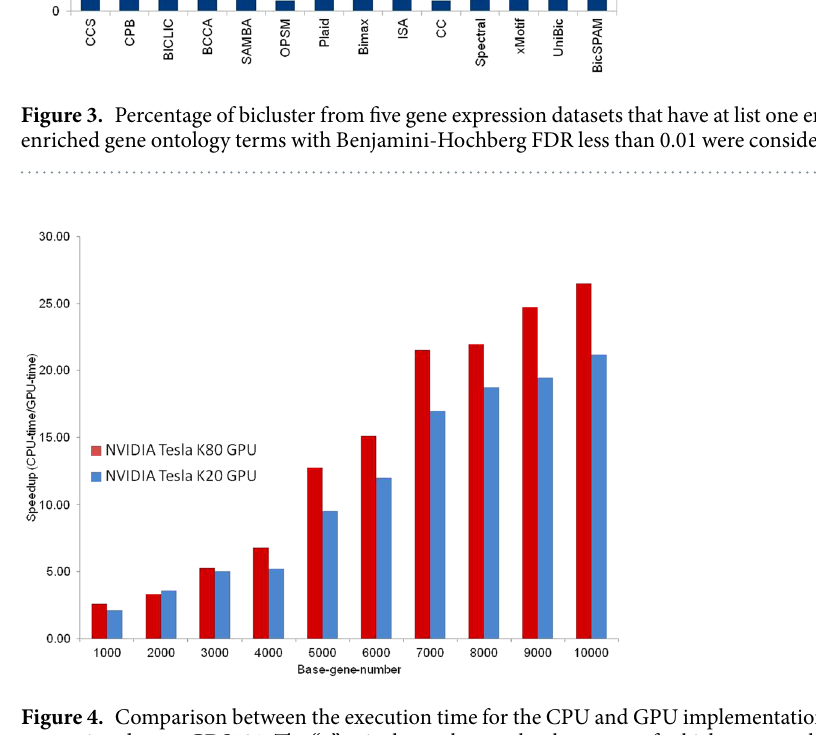
Figure 4. Comparison between the execution time for the CPU and GPU implementations of CCS on gene expression dataset GDS531. The “x” axis shows the number base genes for bicluster search. The “y” axis shows GPU speedup from CPU vs. GPU execution times.